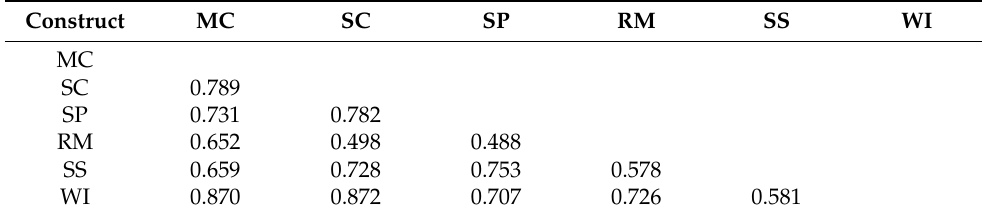
Table 2. HTMT analysis results.